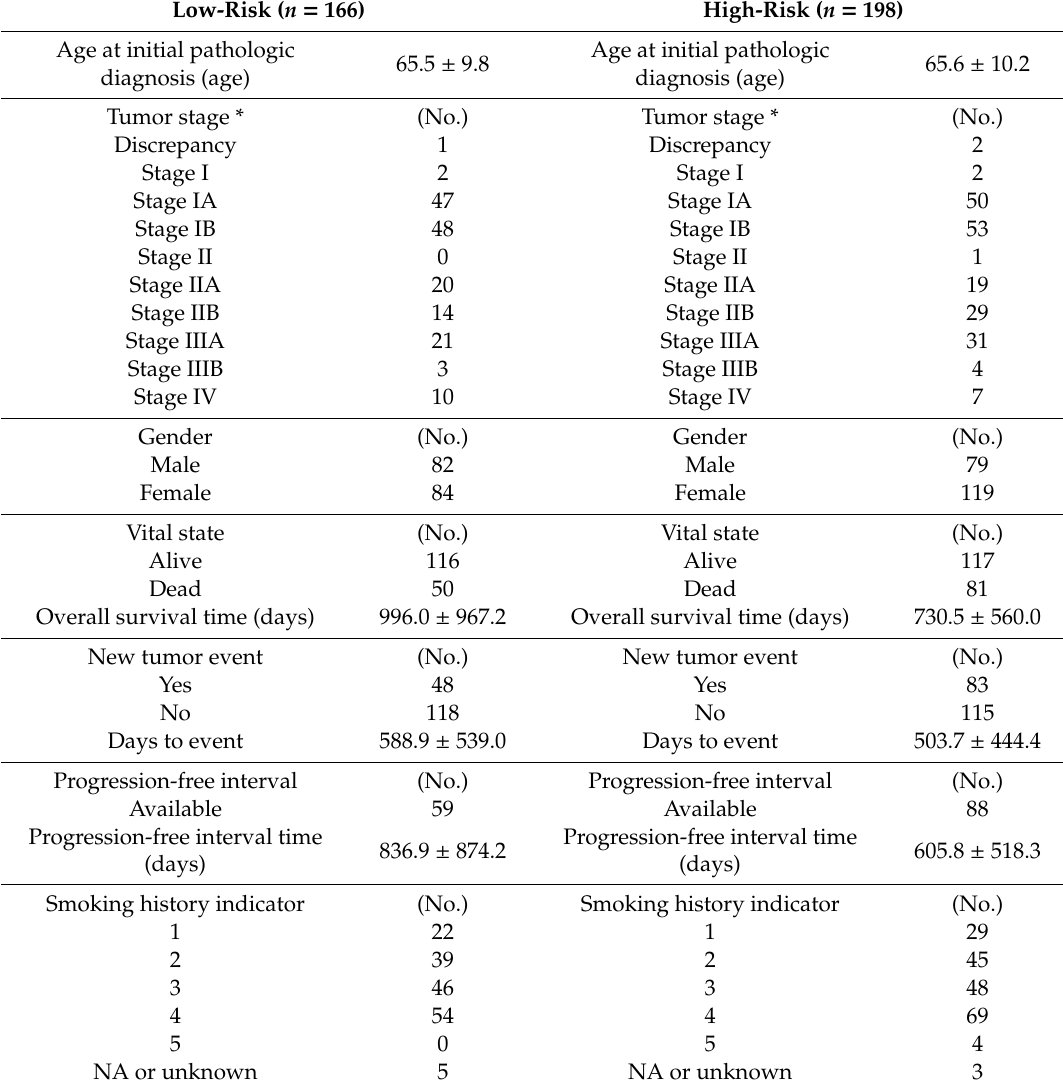
Table 4. Clinical characterization in LUAD low-risk and high-risk